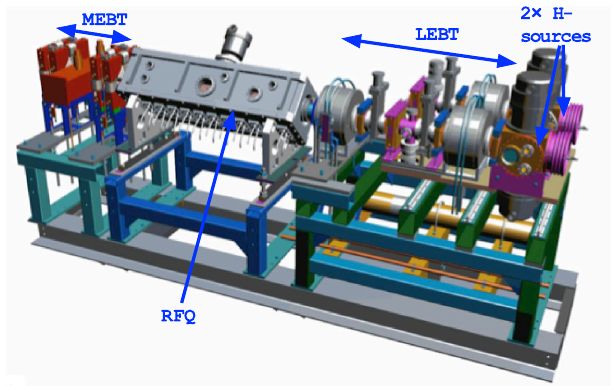
FIG. 1. A 3D CAD drawing of the new RFQ injector. There are two H − sources for redundancy, a short LEBT, RFQ, and a very short